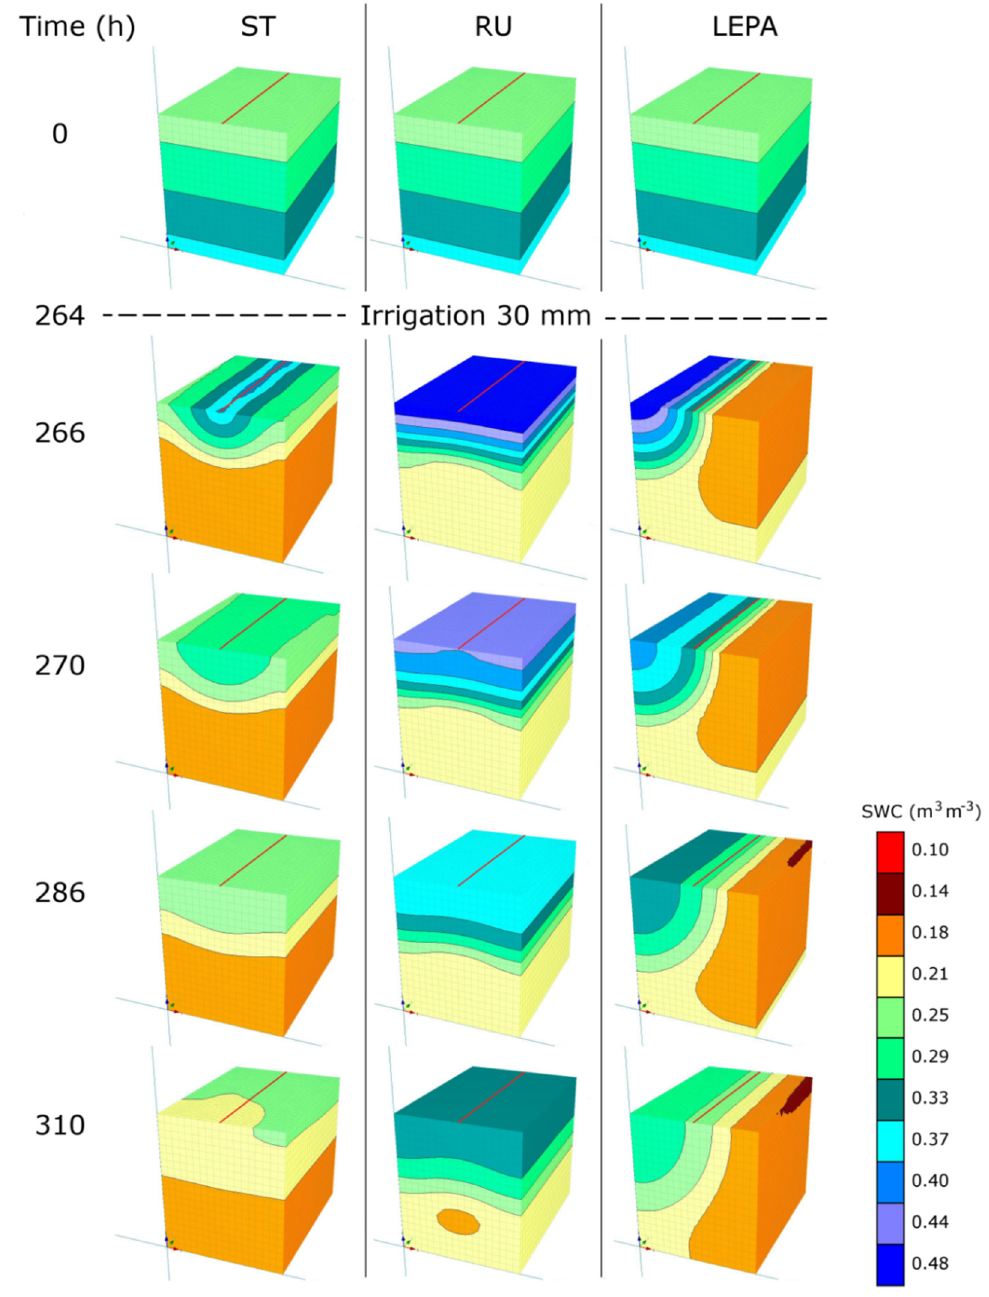
Figure 11. Visual 3D representation of soil water content (SWC, m 3 ·m − 3 ) in the 3D HYDRUS domain under full irrigation and characterized by: ST, stemflow/throughfall redistribution; RU, uniform rainfall application; LEPA, low-energy precision application system. The maize row is placed in the middle position of the soil domain (red